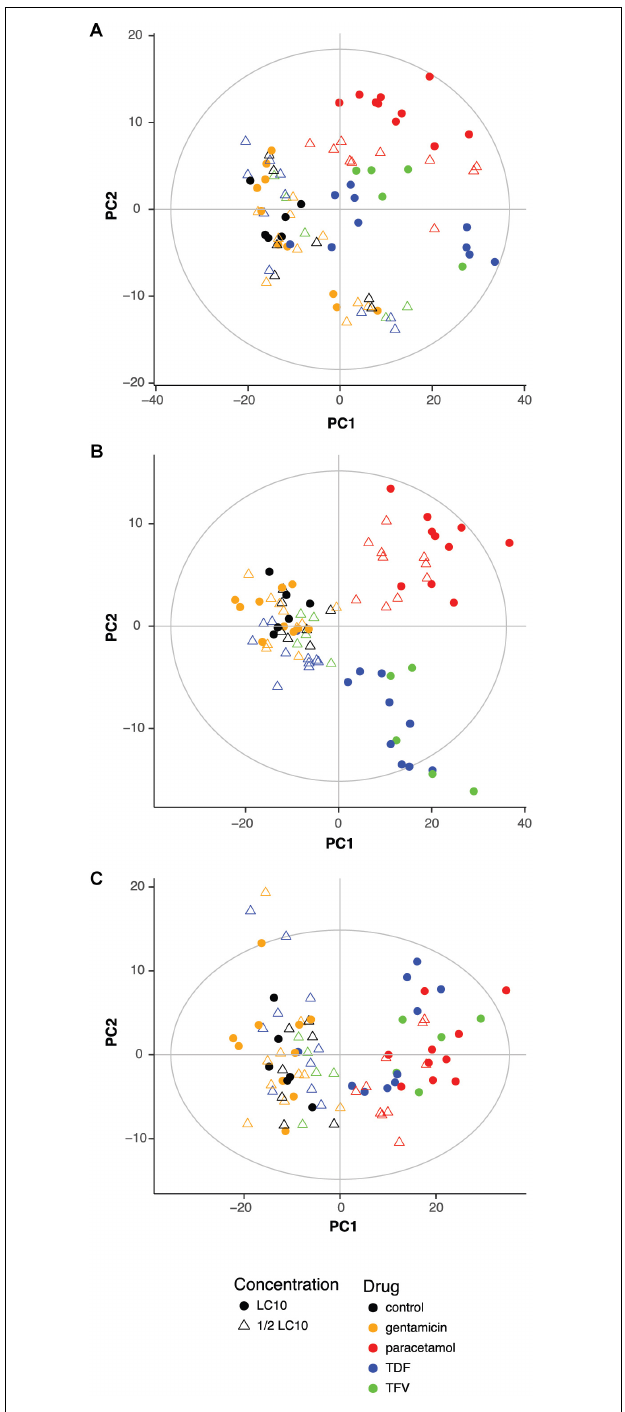
FIGURE 2 | Influence of drug and concentration on the metabolic profile. Score plot of the PCA of the 83 zebrafish samples without (A) and with correction (B) of extraction block effect showing the influence of drug and concentration. (C) Score plot of the PCA of the 83 zebrafish samples after correction for the extraction block effect and after exclusion of exogenous compounds effect showing the influence of drug and concentration. LC10, lethal concentration for 10% of zebrafish larvae; TDF, tenofovir disoproxil fumarate; TFV,